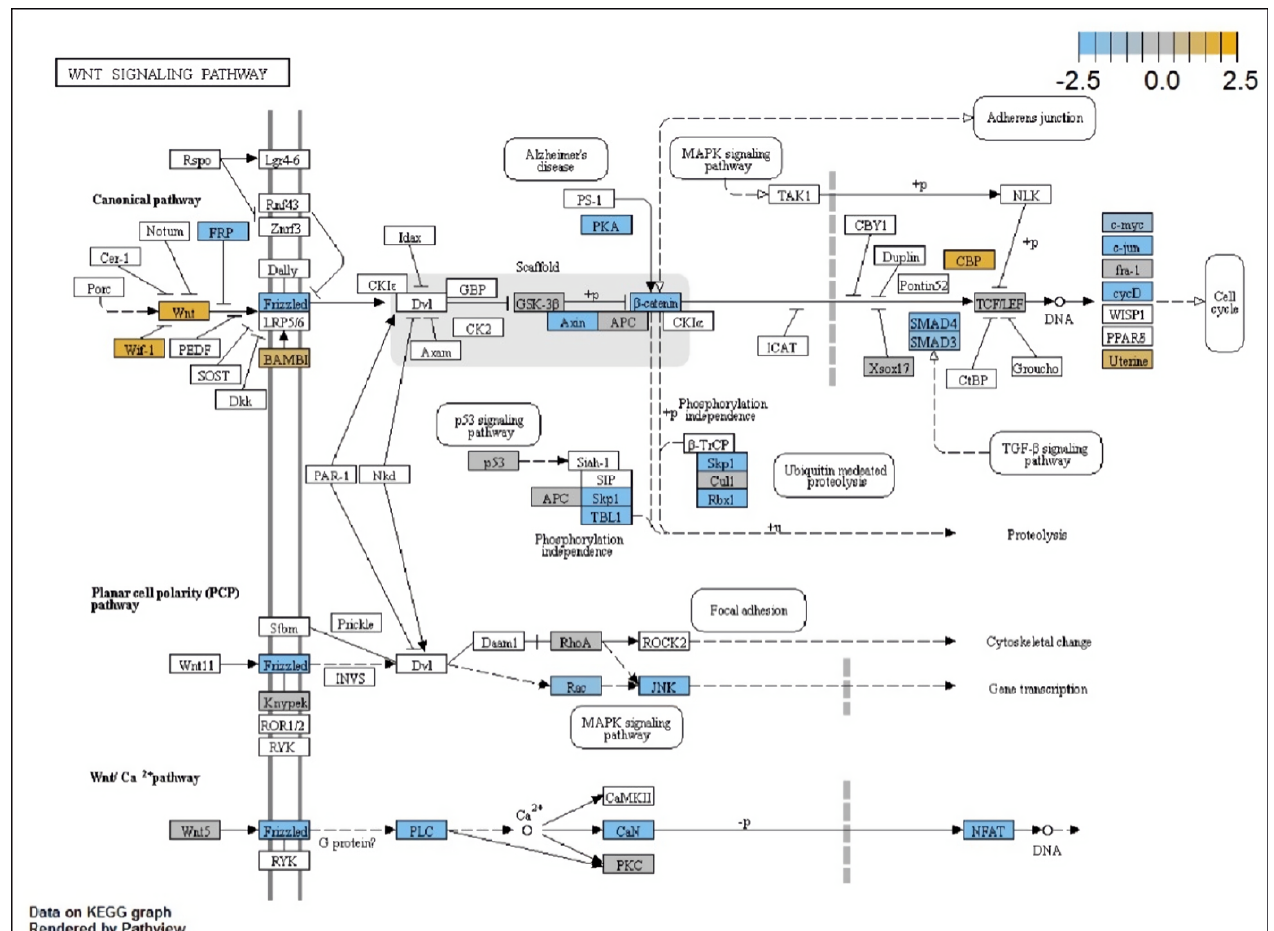
Figure 3. Pathview analysis done by NanoString nSolver software showing a comprehensive pathway roadmap for differentially expressed genes within WNT signaling pathways. Elements overexpressed are shown in gold, elements underexpressed are shown in blue, and elements with unchanged expression are shown in gray.